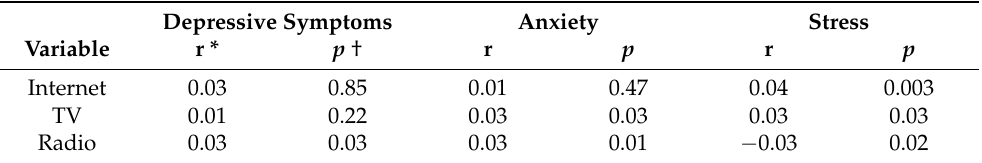
Table 4. Correlation of depressive symptoms, anxiety, and stress with exposure to infodemic of the elderly during the COVID-19 pandemic. Peru, 2021. Depressive Symptoms Anxiety Stress Variable